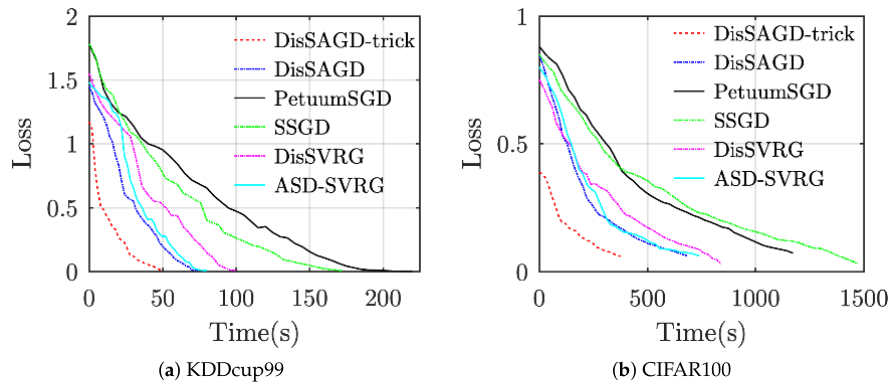
Figure 4. Compare convergence performance by using 4 computational